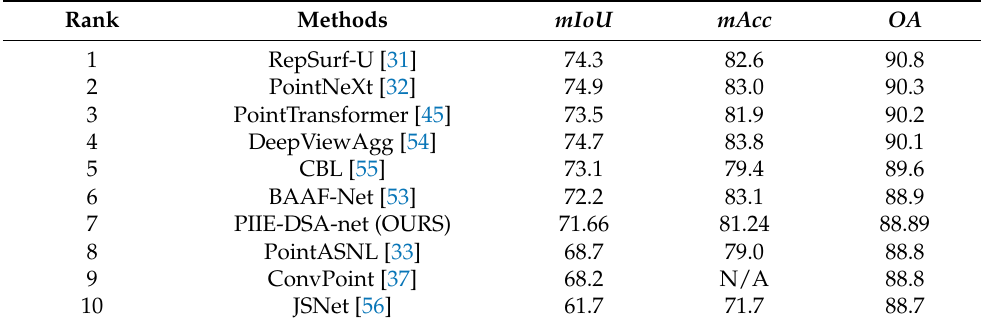
Table 2. Current overall TOP-10 ranking of the six-fold experiments on the S3DIS dataset